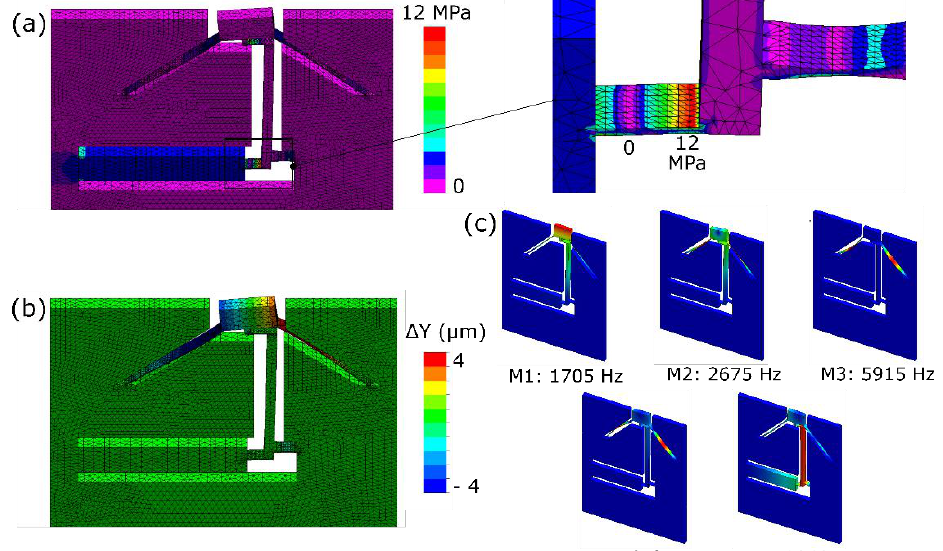
Figure 2. Results of the prescribed displacement analysis simulation corresponding to a 0.5 μm displacement applied to the actuator showing the ( a ) corresponding stress plot with a maximum stress level equal to 12 MPa and ( b ) total displacement along the y -axis (the figures are in the x - y plane with the z axis pointing outwards and y axis pointing upwards). ( c ) Natural vibrating modes of the device (Note that the vibration-induced displacements are exaggerated for visualization purposes).